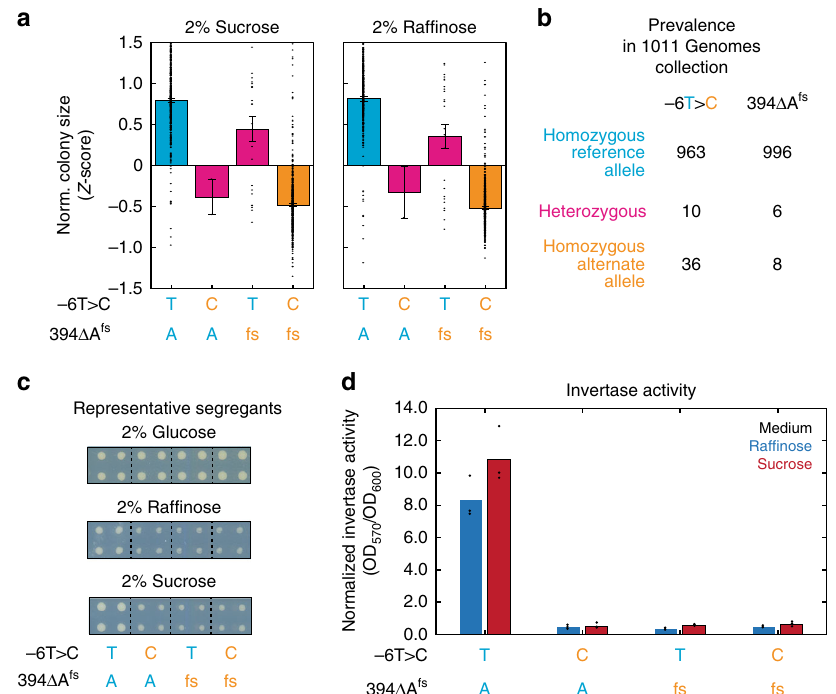
Fig. 2 Neighboring QTNs in a compound QTL. a ) Growth phenotypes of segregants with the parental ditypes ( SUC2 − 6T/394A , blue; SUC2 − 6C/394fs , orange) and nonparental ditypes ( SUC2 − 6T/394fs and SUC2 − 6T/394fs , pink). Data shown are mean ± s.e.m of normalized, Z -scored colony size for each ditype. b Prevalence of the causal SUC2 variants shown in ( a ) across 1011 sequenced S. cerevisiae isolates 28 . c Growth of representative segregants with genotypes as in ( a ). Shown are technical quadruplicates arrayed in squares; panels are representative of N = 8 biological replicates. d Normalized invertase activity of representative segregants with genotypes as in ( a ) when grown in media containing raf fi nose (blue) or sucrose (red), as indicated. Data shown are N = 3 biological replicates; bars show the mean. Source data are provided as a Source Data fi le